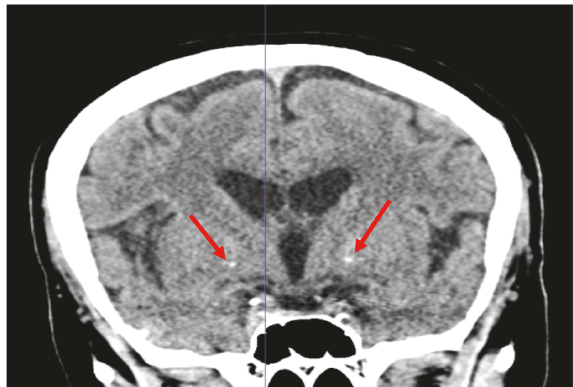
Figure 3: CT scan without contrast showing mild to moderate bilateral periventricular and deep white matter low attenuation along with trace bilateral basal ganglia